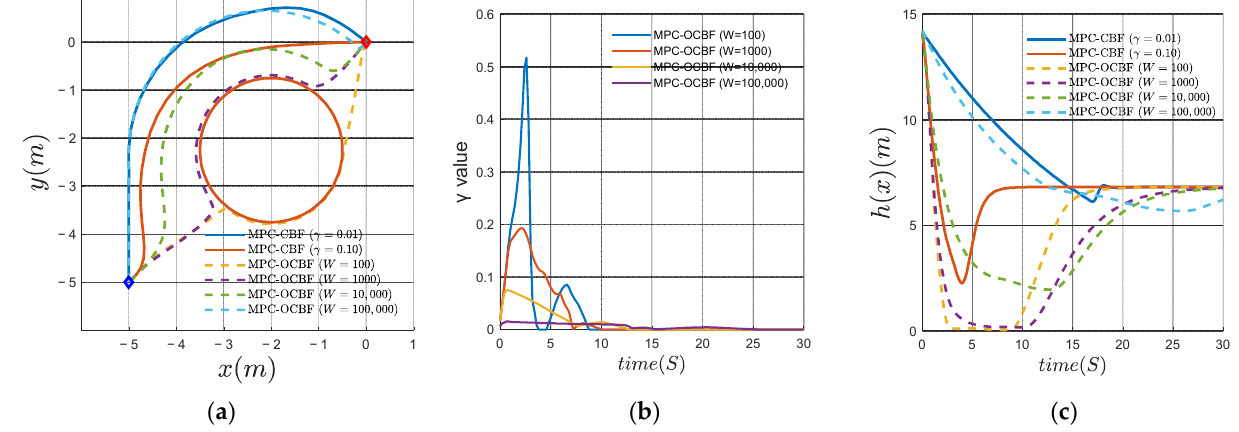
Figure 2. Compare the conservative obstacle avoidance behaviors generated by MPC-CBF ( N = 8) and MPC-OCBF ( N = 2 ): ( a ) the trajectory of MPC-CBF and MPC-OCBF; ( b ) the optimized γ value of MPC-OCBF with different weight matrices; ( c ) the CBF h(x) values of MPC-CBF and